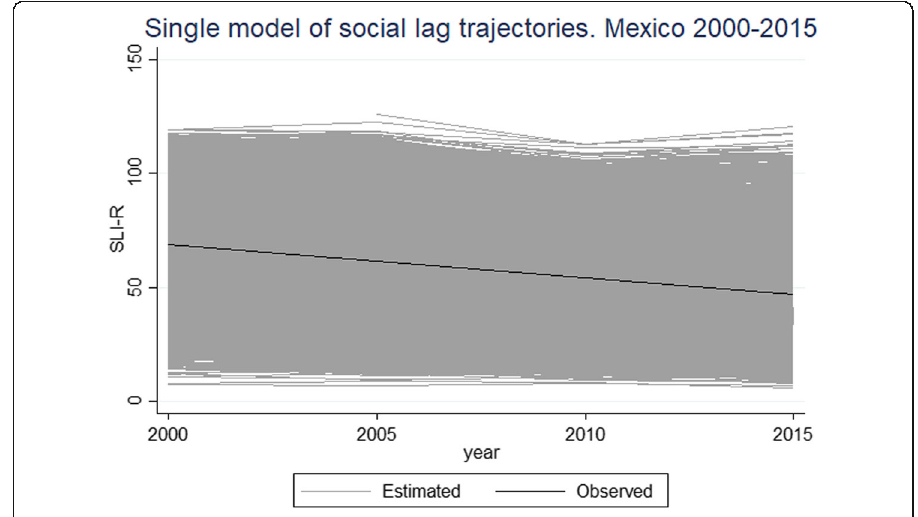
Fig. 2 Latent growth curves of